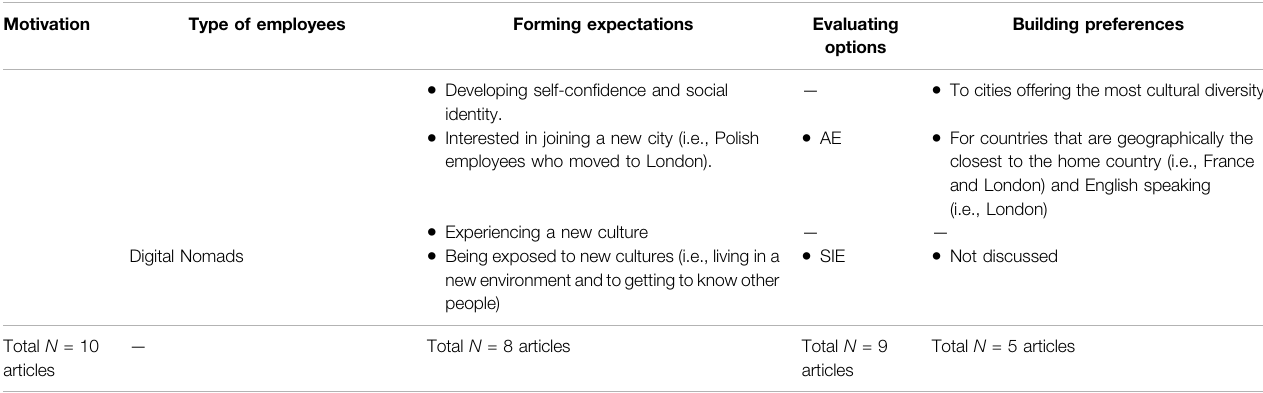
TABLE 2 | ( Continued ) Overview of the motivation process for all four motivations and the different types of